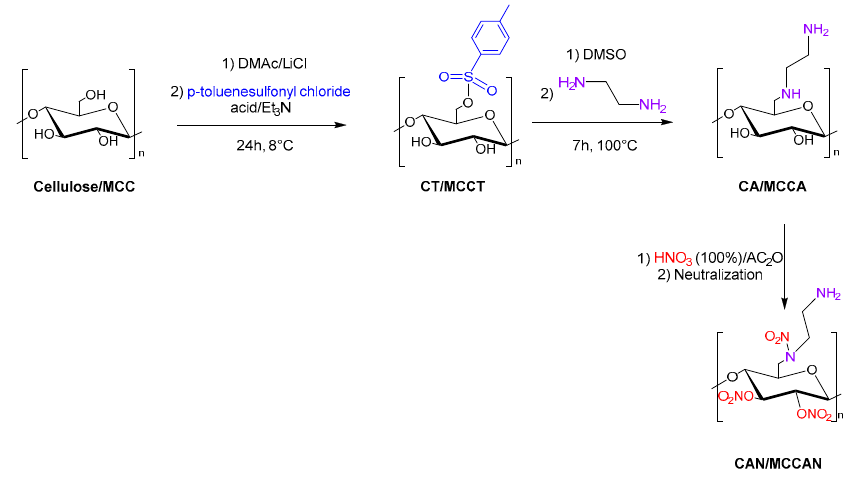
Figure 13. Synthesis of CAN and